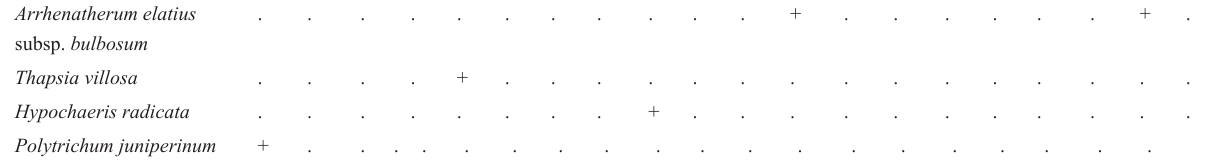
Table 8. Plots recorded in the “Ermita” area (Er , not burned). For all plots, the altitude is 1000 m asl. Indexes correspond to those of Br.-Bl. 1964. NB See text for more explanations on plant communities and syntaxa. N. Species Plot N.